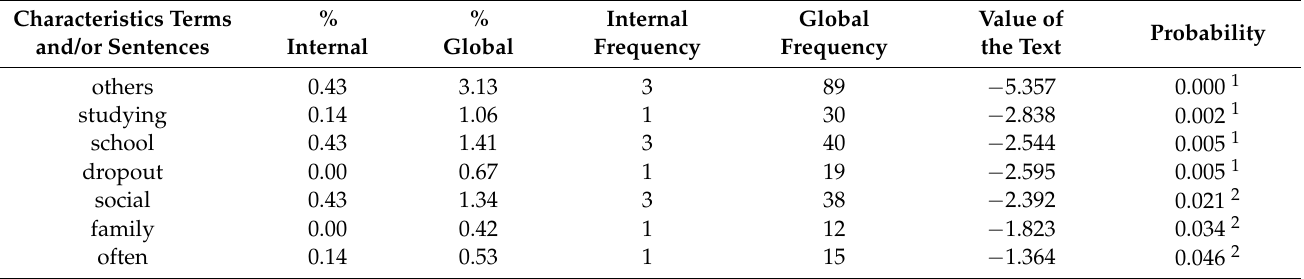
Table 6. The words less used by the parents in answer to the question: “How the family might prevent school dropout?”.